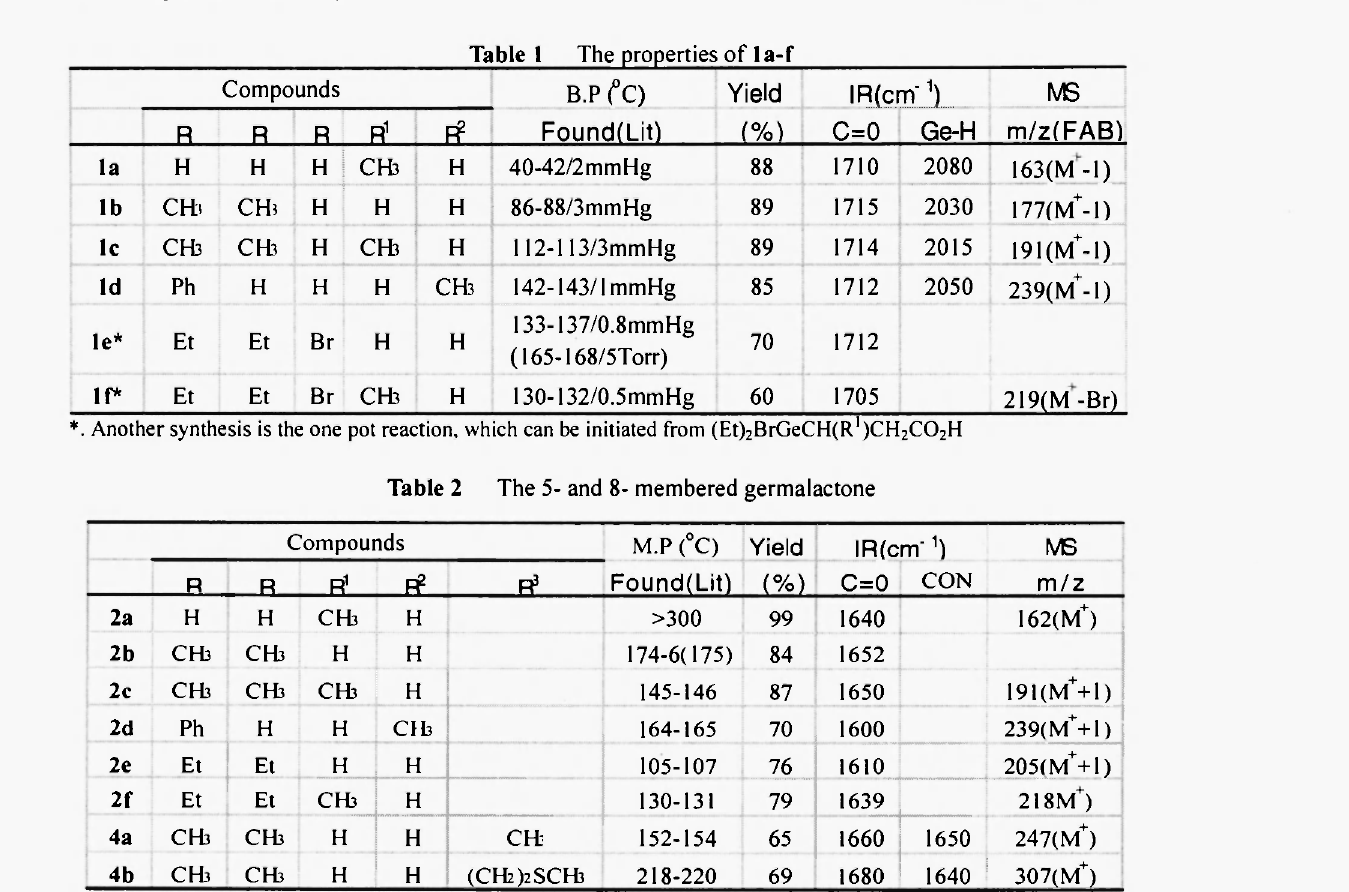
The 5- and 8- membered